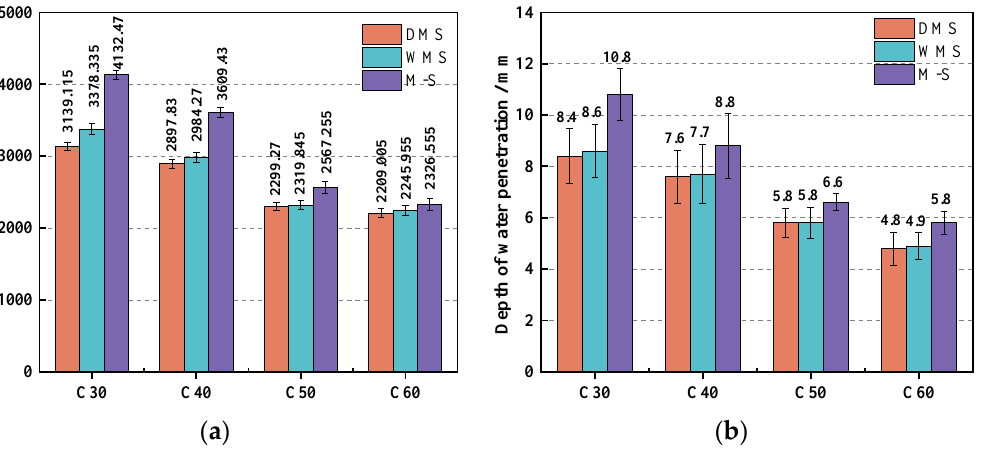
Figure 13. Anti-chloride ion erosion performance and water penetration resistance of each group: ( a ) electric flux of concrete; ( b ) depth of water penetration of concrete. The water-penetration resistance of concrete can also indicate its penetration